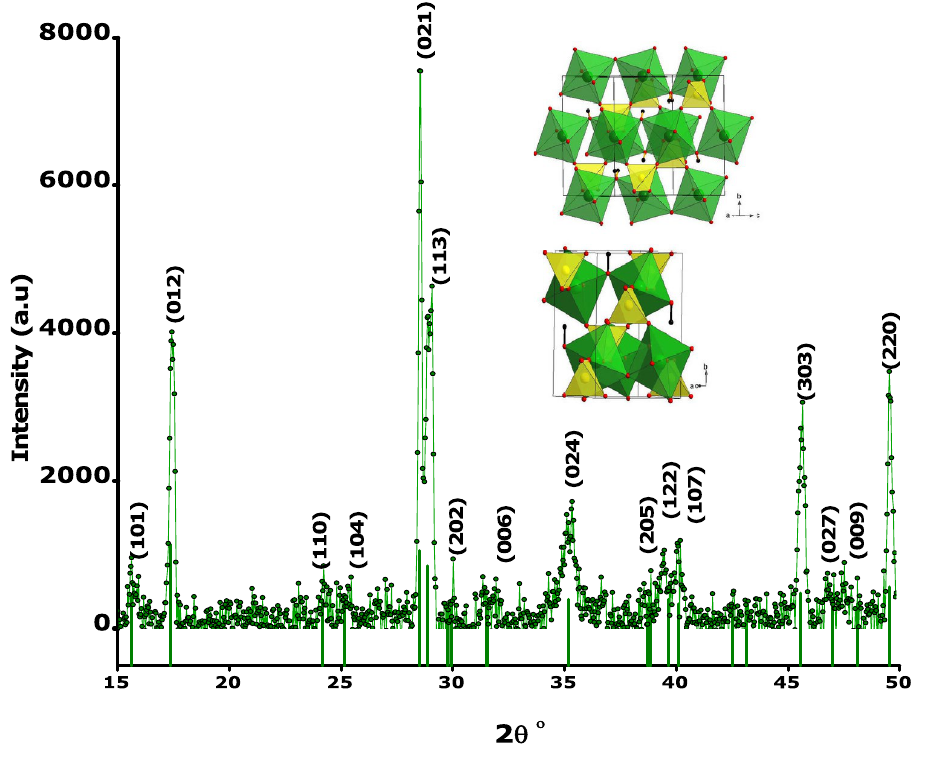
Figure 3. X-ray diffraction in comparison with the standard JCP2_31-0650 card data.